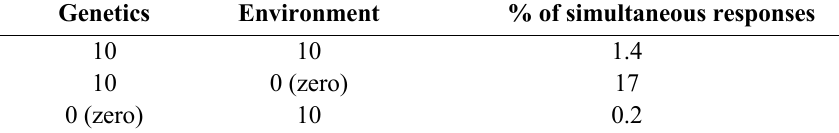
Percentages of simultaneous responses to extreme values on numerical scales from 0 to 10 to the degree of genetic or environment influence on mental